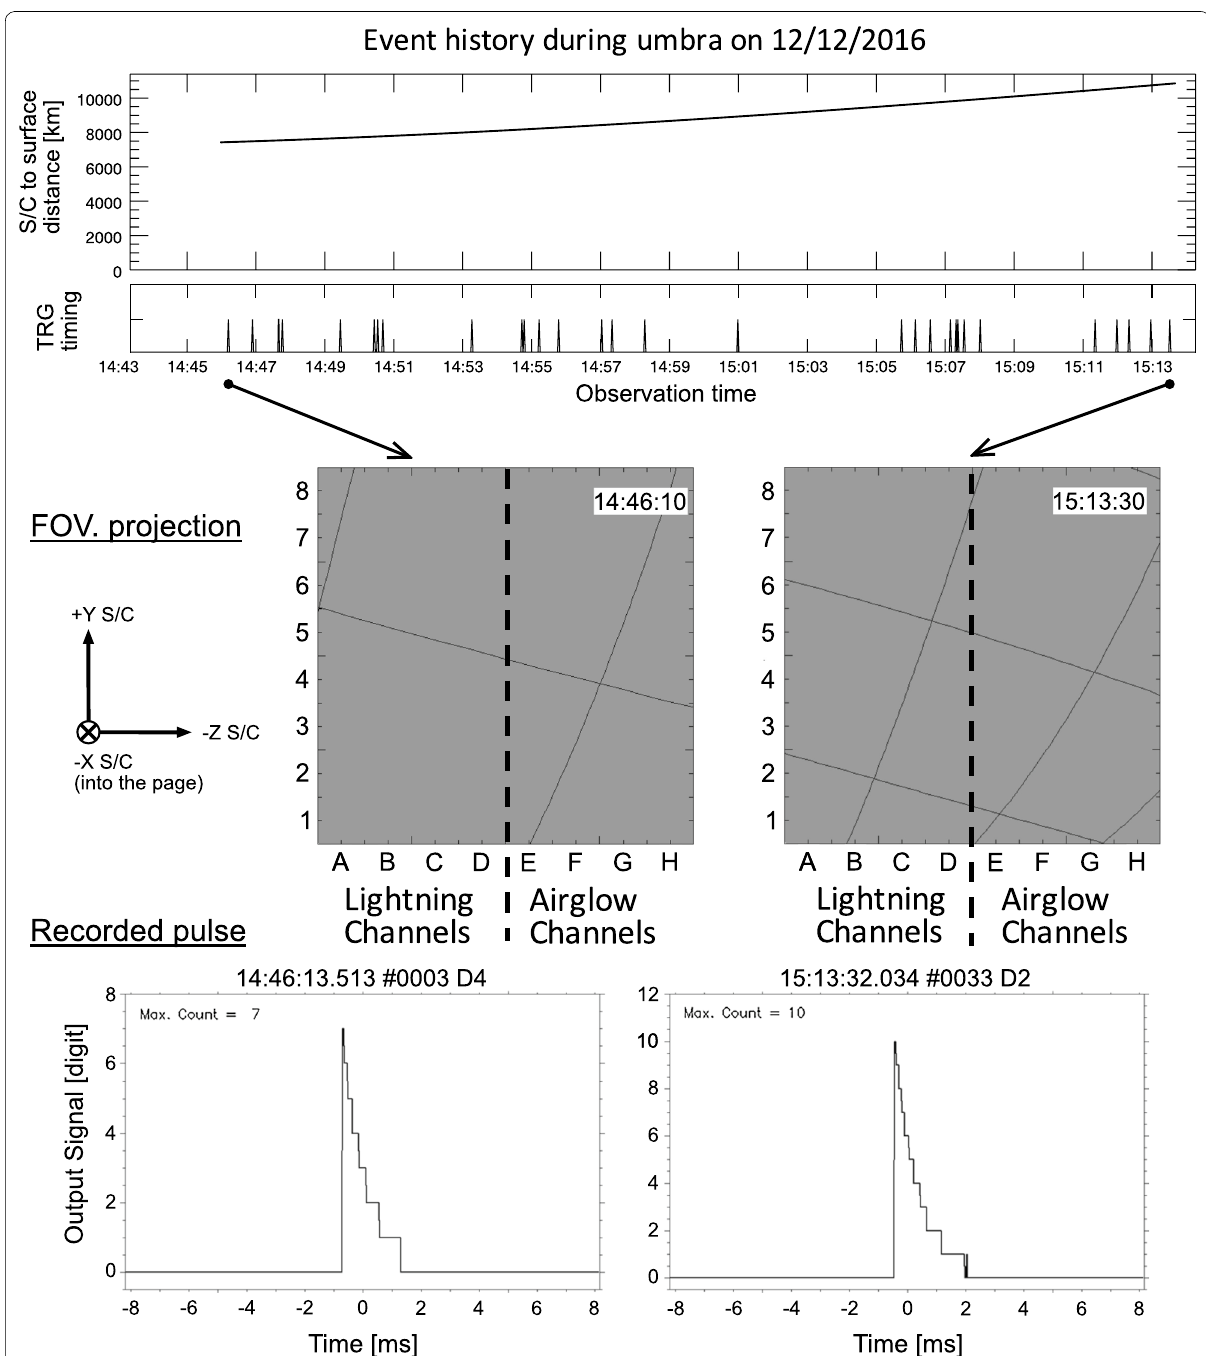
Fig. 3 An example of one pass observation. The top and second panels show the distance from Venus surface and the occurrence of triggered events for cosmic rays (CR) and lightning (LIG). The third and fourth panels express LAC’s FOV and examples of time variation during a cosmic ray